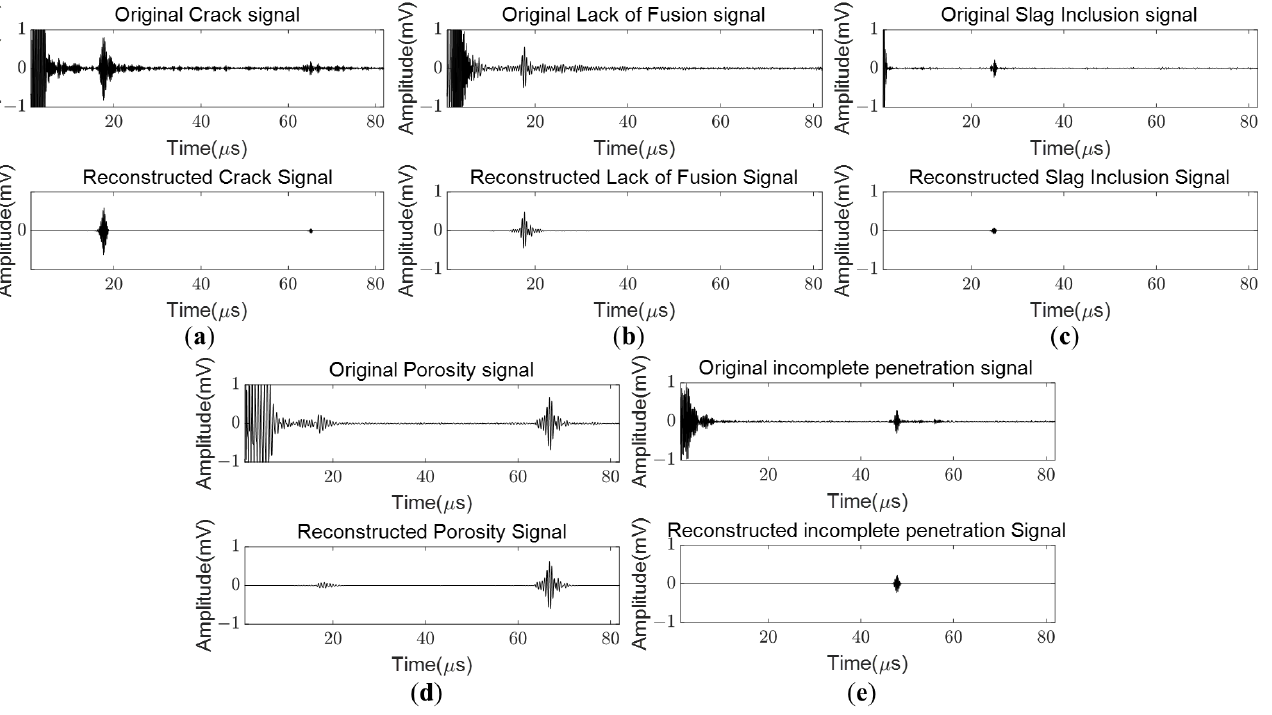
Figure 10. The examples of the performance testing of each flaw types: ( a ) A-scan mixed crack signal (original signal) and extracted crack flaw signal from the original signal; ( b ) A-scan mixed lack of fusion signal (original signal) and extracted lack of fusion flaw signal from the original signal; ( c ) A-scan mixed slag inclusion signal (original signal) and extracted slag inclusion flaw signal from the original signal; ( d ) A-scan mixed porosity signal (original signal) and extracted porosity flaw signal from the original signal; ( e ) A-scan mixed incomplete penetration signal (original signal) and extracted incomplete penetration flaw signal from the original signal.